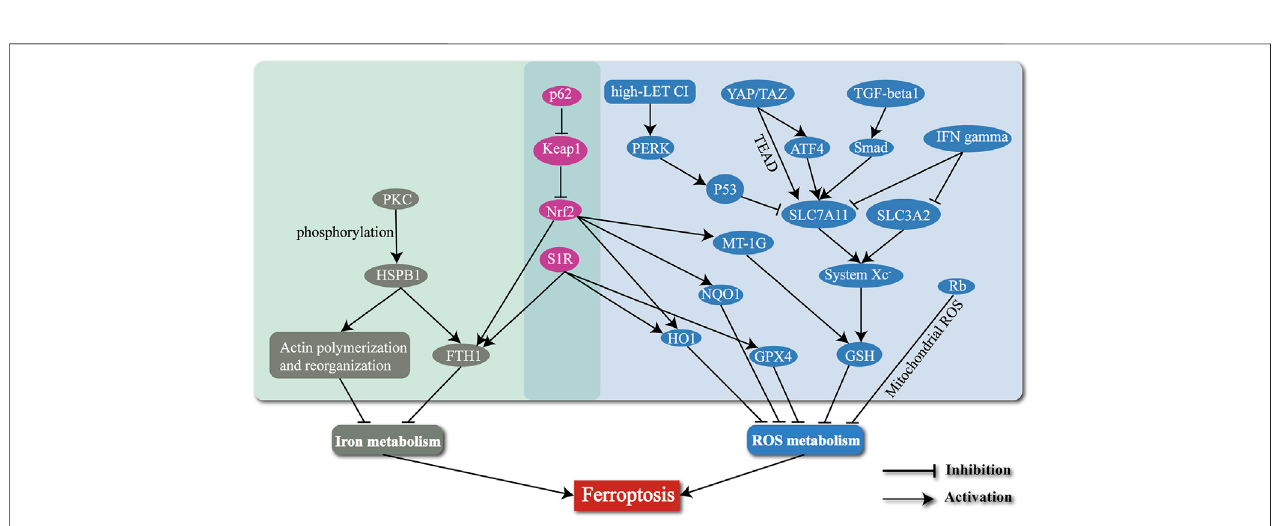
FIGURE 2 | The mechanisms of regulating the ferroptosis process in HCC by several typical molecules and radiotherapy.